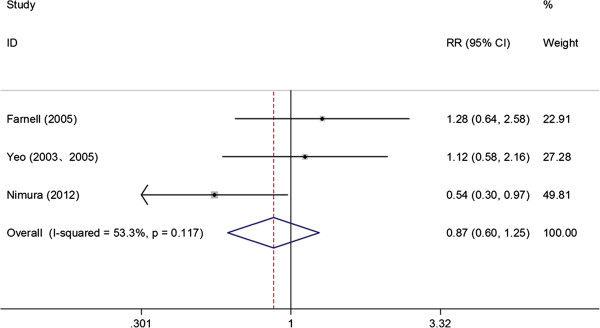
Forest plot for the 1-year survival rate between the pancreatoduodenectomy with extended lymphadenectomy (PD/ELND) group and the standard pancreatoduodenectomy (PD) group. On the left, the name of the first author of the study is followed by the publication year. The size of the black box corresponding to each study is proportional to the sample size, and the horizontal line shows the corresponding 95% CI of the relative risk (RR) displayed on the right.